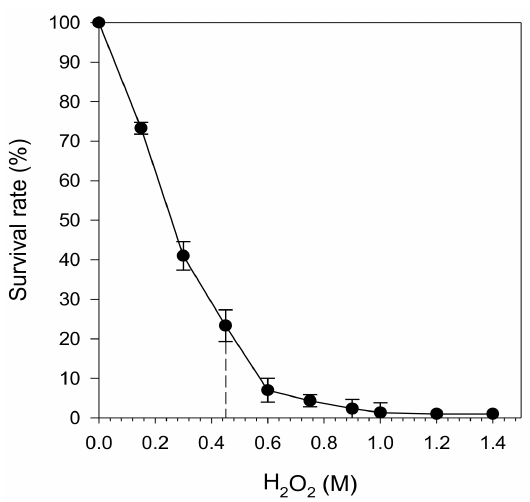
Figure 2. Survival of the yeast strain SKQ2n (expressed as percentage of initial cell concentration) as a function of 10 min exposure of different H 2 O 2 concentrations. A concentration of 0.45 M (dashed line) was selected to perform the stress